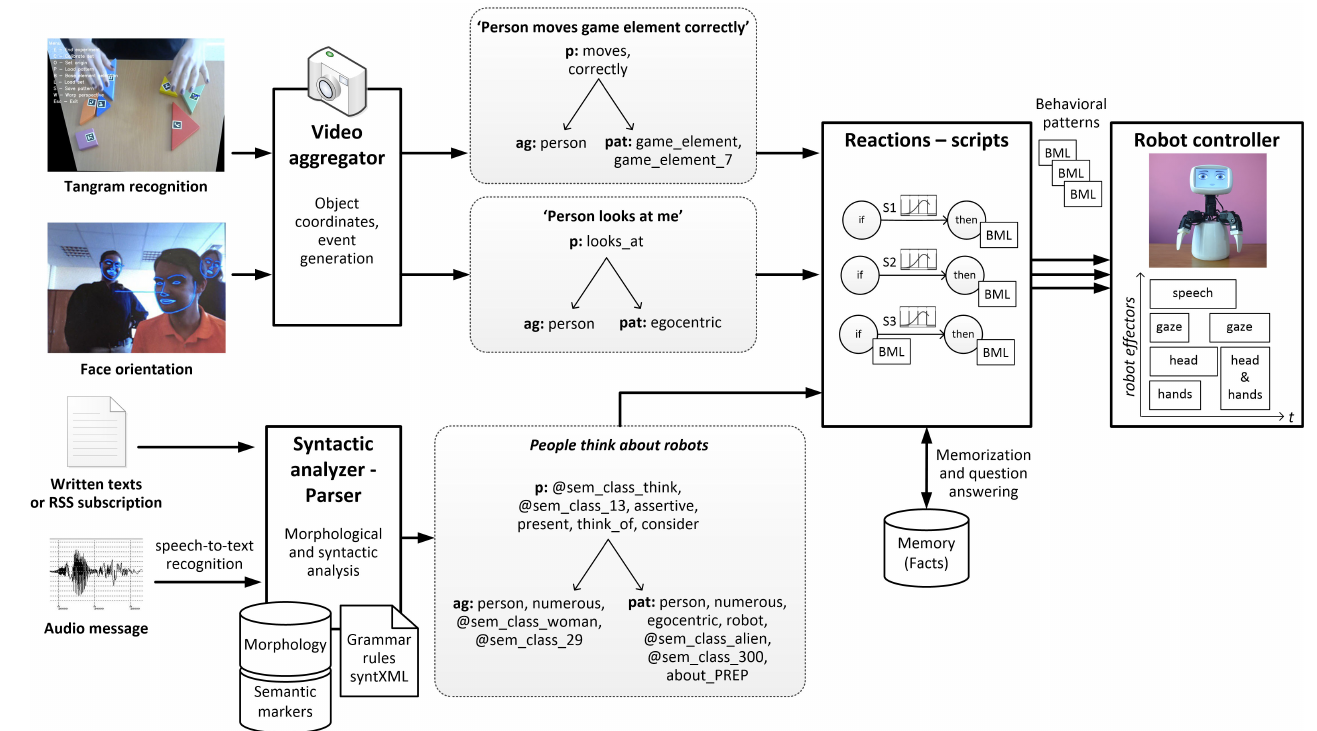
Figure 2. The extended processing architecture of the F-2